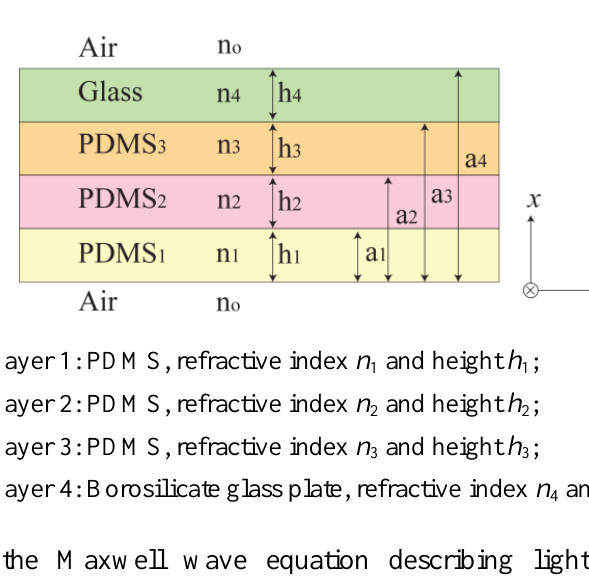
Figure 3. Structure of the multilayer optical